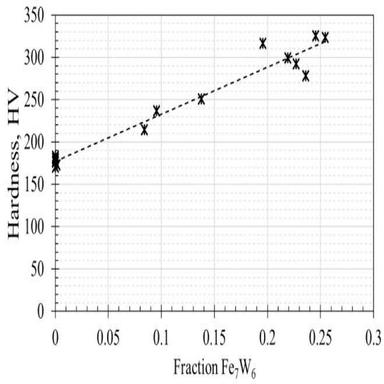
Hardness as a function of the area fraction of Fe7W6.